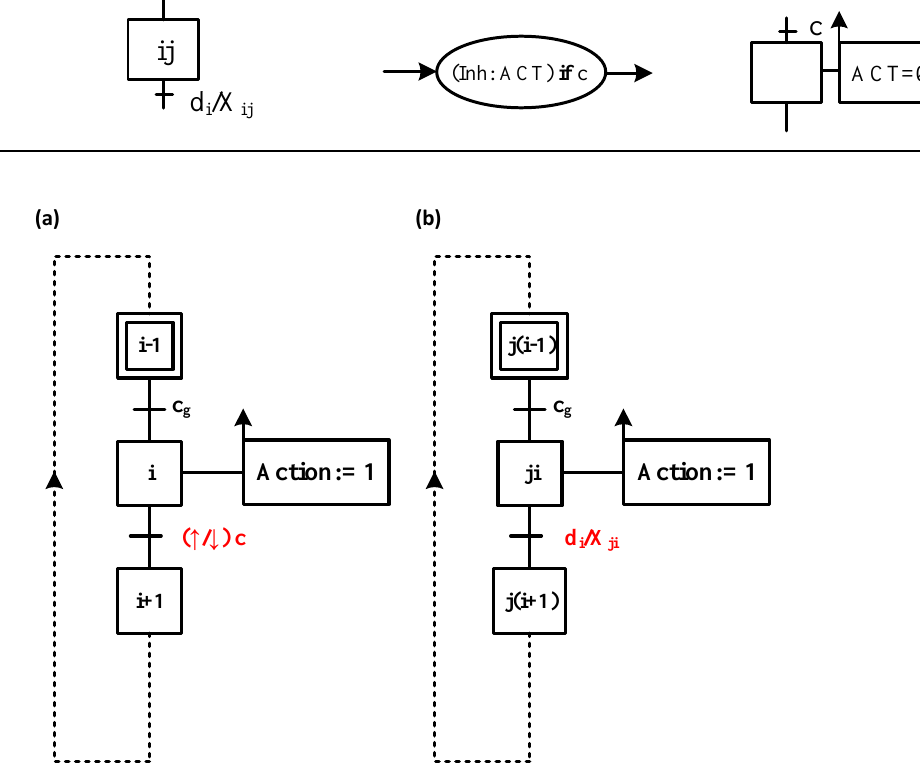
Figure 5. Grafcets extracts ( a ) G 7(N) ,( b ) G 7(F).